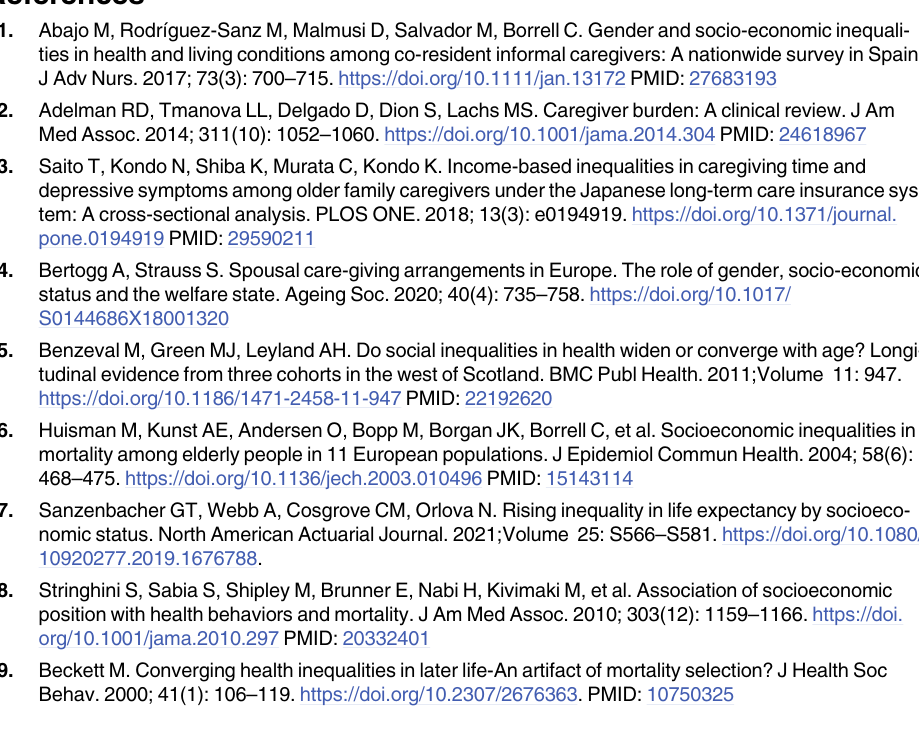
(household income for father-in-law) to 680 (living and housing conditions for mother). The bar represents the 95% confidence interval. The dependent variable is a binary variable that takes unity if the father, mother, father-in-law, or mother-in-law requires care at home at the time of the survey, and zero if he/she receives care at a facility. Each panel shows a different SES measure. S1 Table. Relationship between missing observations in household income and financial assets and self-rated health. S2 Table. Balance of SES measures with and without the inverse probability weighting. S3 Table. Summary statistics for the outcome variables in the analyses for possible mecha-